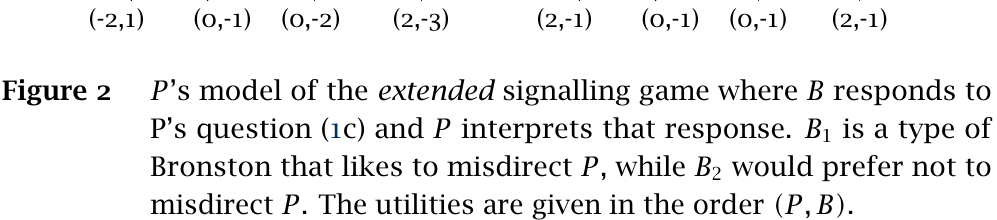
is a type of 1 would prefer not to 2